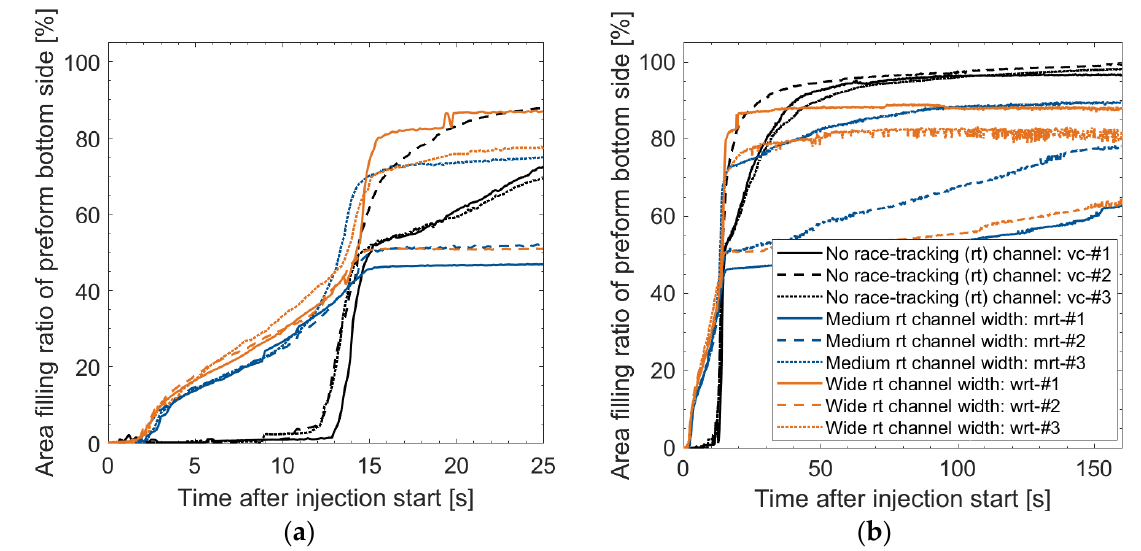
Figure 8. Area filling ratio of preform bottom side: ( a ) during the first 25 s of the process; ( b ) until gel time of representative snap-cure resin system. For legend of both plots see ( b ).